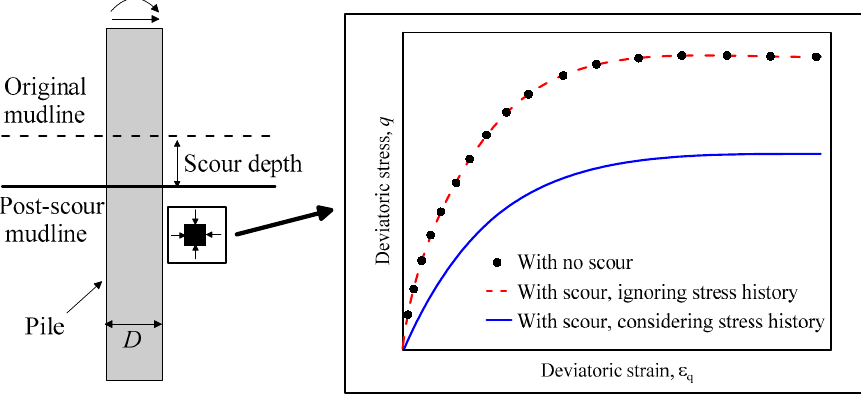
Figure 1. Schematic diagram of the stress-strain curve of the remaining soil after scour.